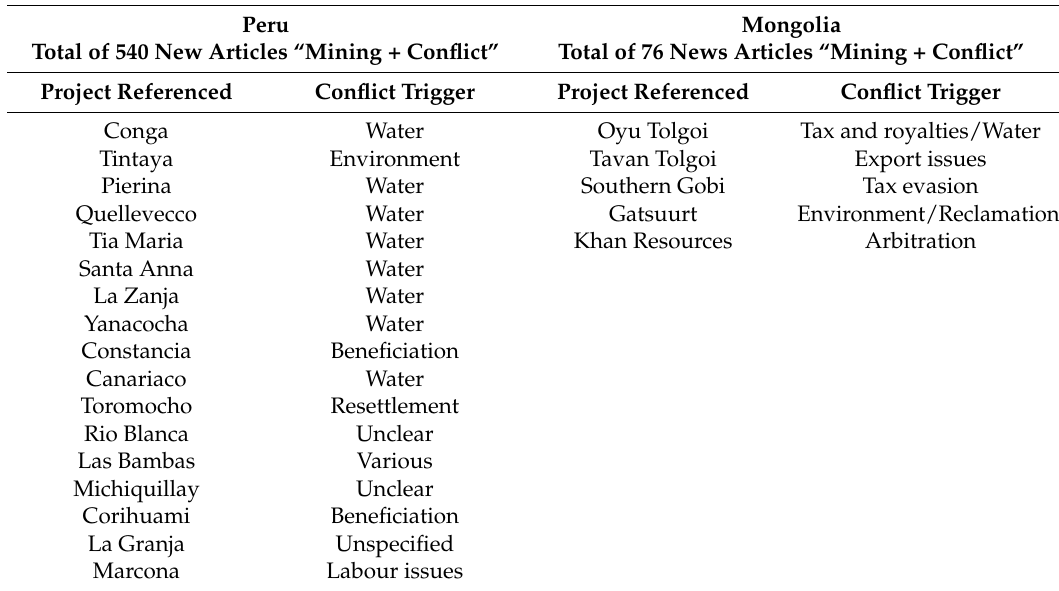
Table 1. Projects affected by mining-community conflict with the trigger for conflict as reported within the media article. Articles were sourced from the Factiva